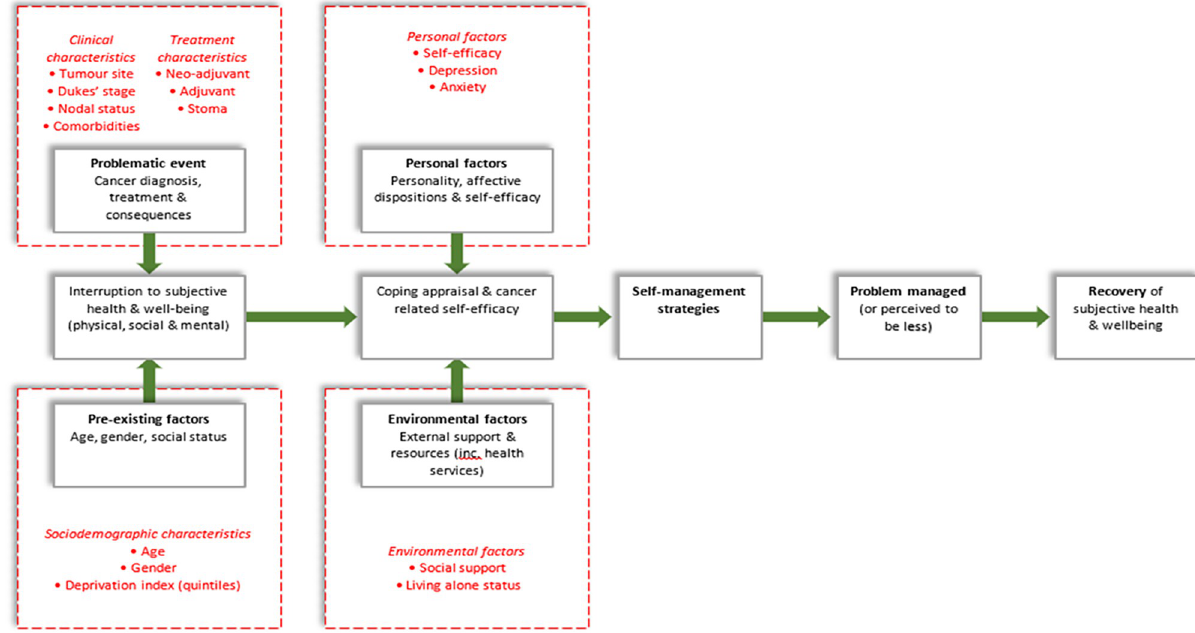
Fig 1. Predictors for older people with CRC mapped onto Foster and Fenlon’s conceptual model of health and wellbeing recovery following cancer treatment.